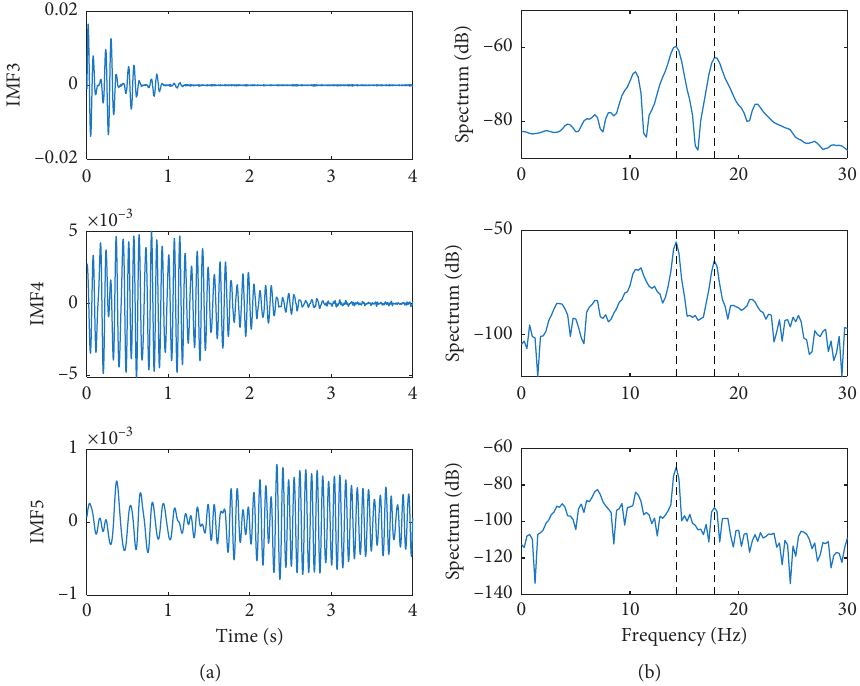
Figure 10: (a) The extracted three modes by EEMD and (b) the corresponding Fourier spectra.